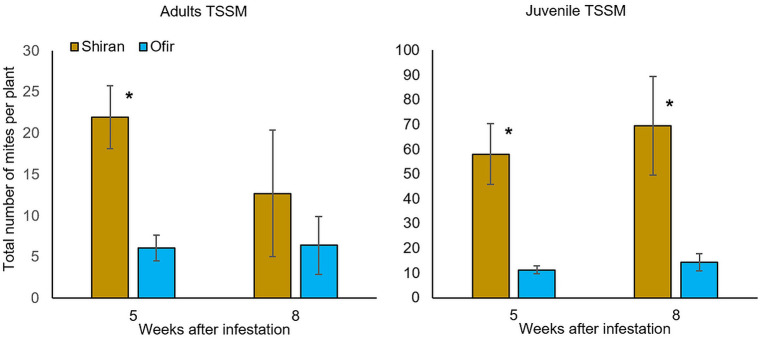
The total number of adult and juvenile TSSMs per plant on the two tomato cultivars grown in a net house. Mite population was counted 5 and 8 weeks after TSSM infestation. At each time point, nine leaves from a plant were selected, twenty plants of each cultivar were sampled (Student's t-test; *p < 0.05; n = 20; mean ± SE). The time points that are presented are the ones in which the peak of the mite population was observed.